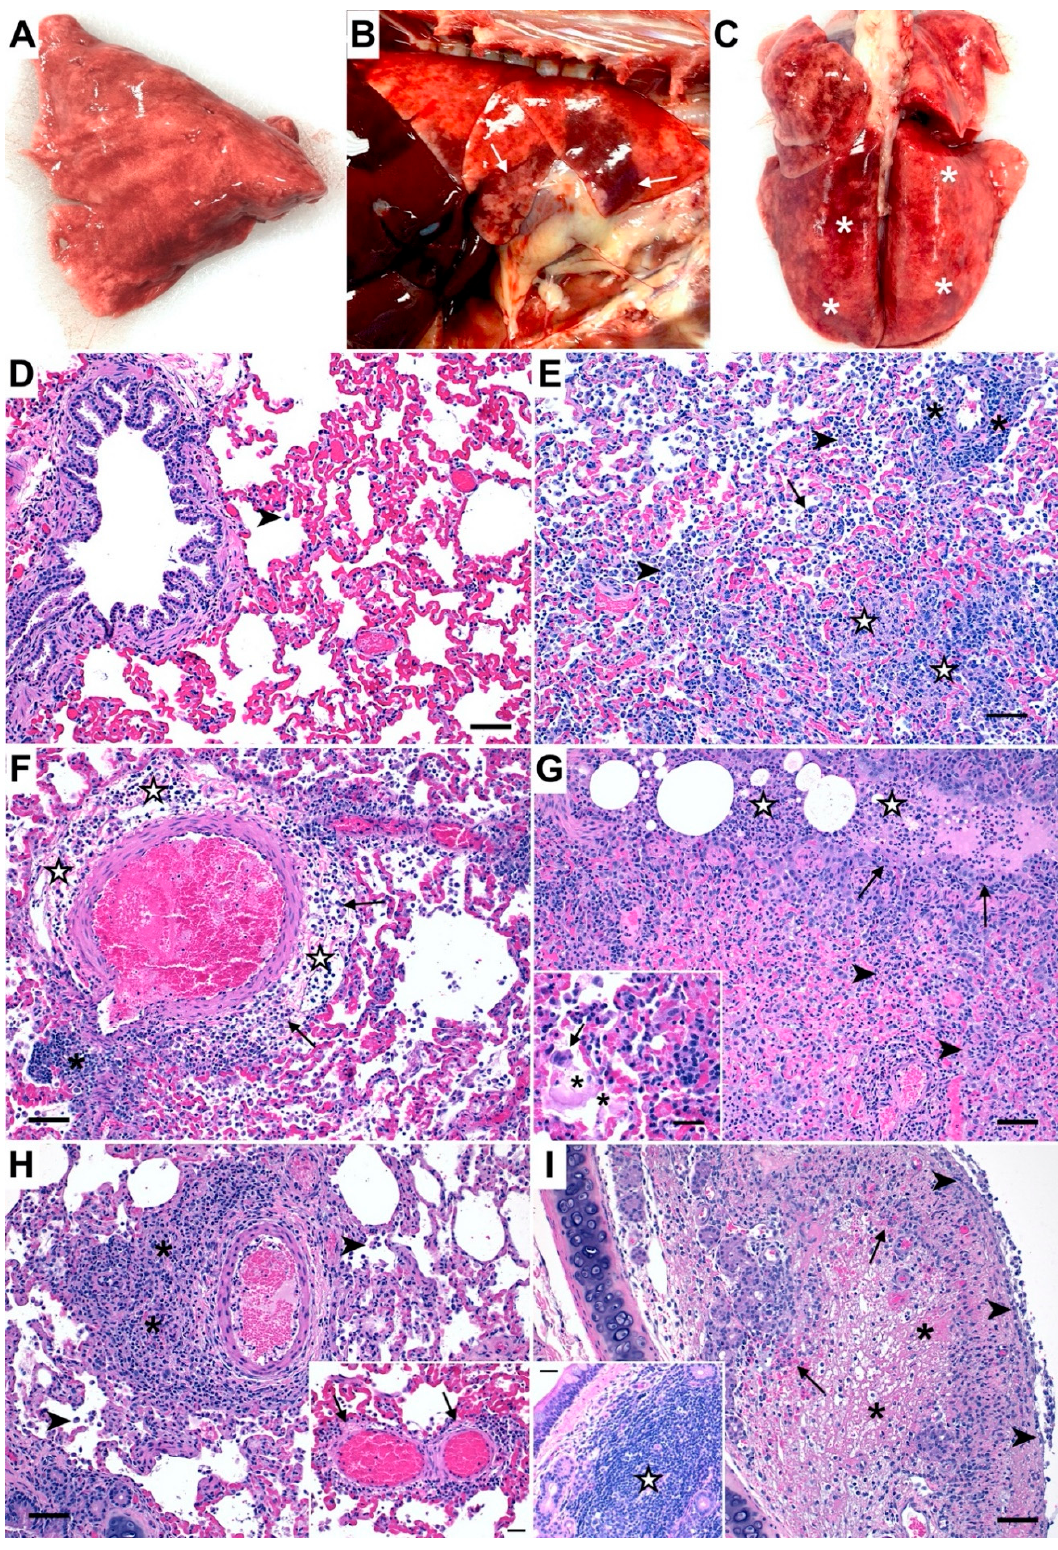
Figure 2. SARS-CoV-2 (Delta variant) infection causes severe pathologic lesions and acute alveolar damage in domestic cats. Compared to lungs from healthy sham-inoculated cats ( A ), the lungs of SARS-CoV-2 (Delta variant) infected cats were markedly consolidated at 4 dpi ( B ), with large,